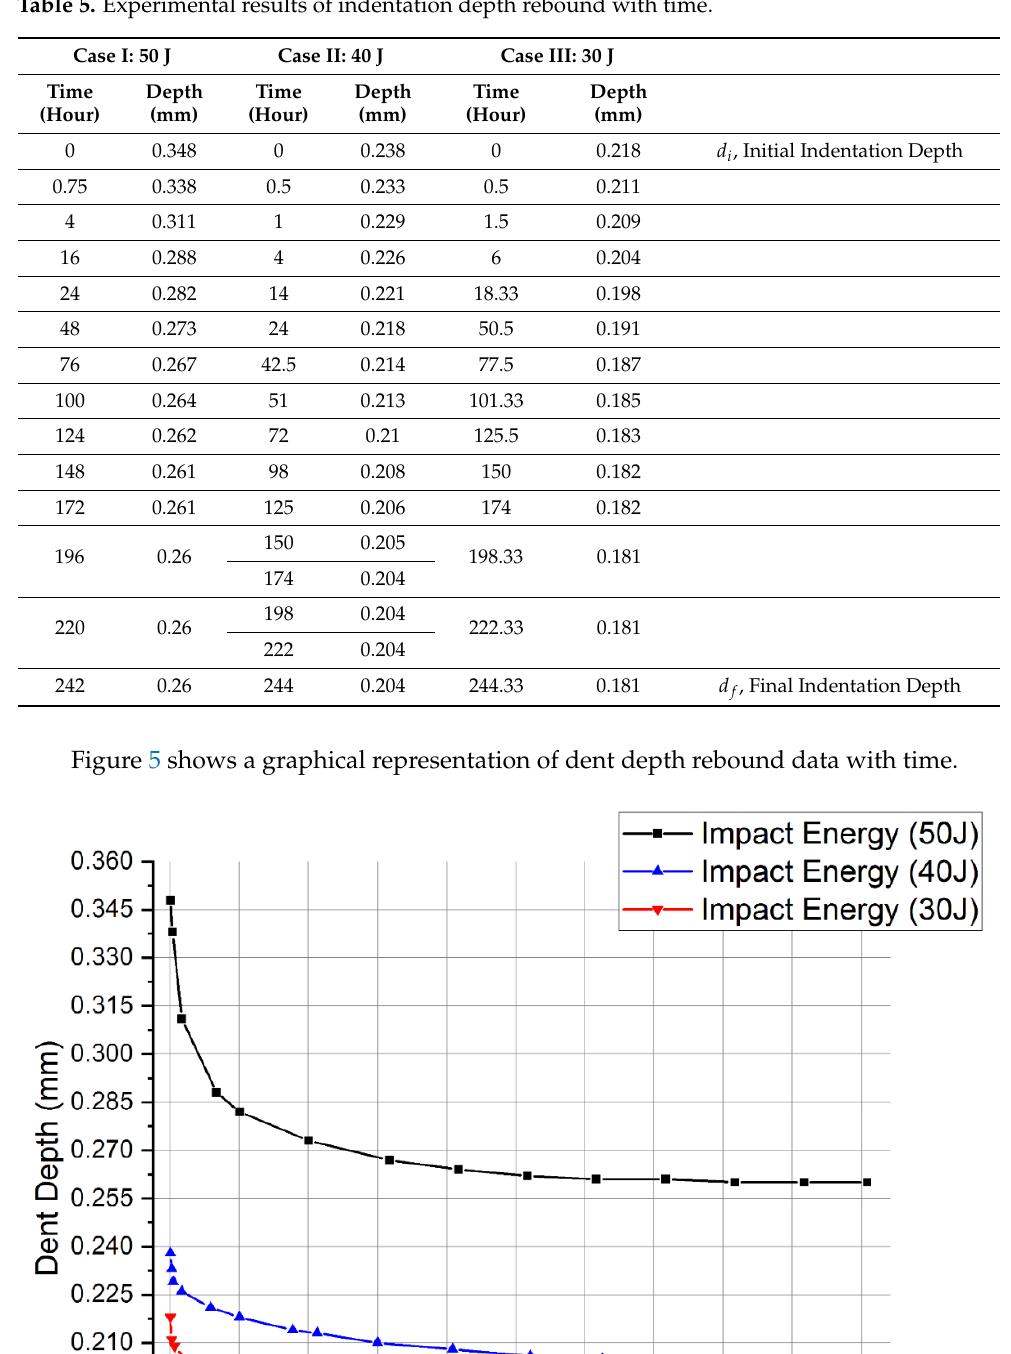
Table 5. Experimental results of indentation depth rebound with time.